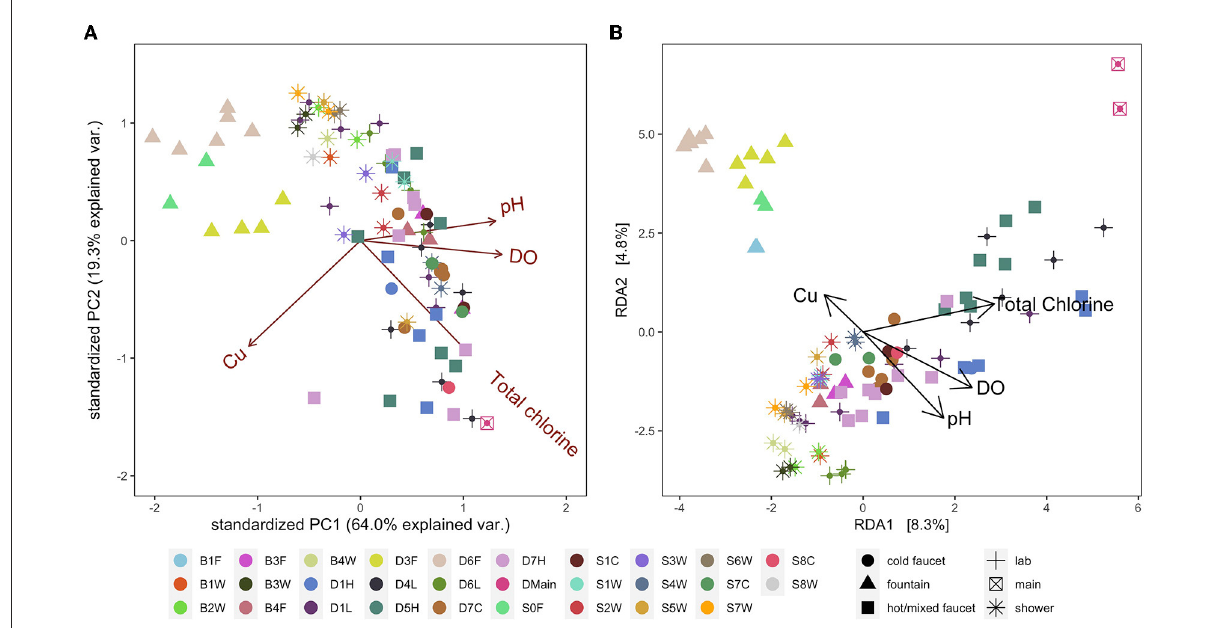
FIGURE6 (A) Principal components analysis (PCA) biplot of selected, significant environmental variables. (B) Aitchison distance redundancy analysis (RDA) biplot illustrating the relationship between selected, significant environmental variables and bacterial community composition. Colors represent fixture ID which is written as one letter indicating the building (D, B, S), followed by the floor number (0–7), followed by one letter indicating the fixture type (W, shower; L, laboratory faucet; F, drinking fountain; H, hot/mixed faucet; C, cold faucet). Shapes represent fixture type for added visual